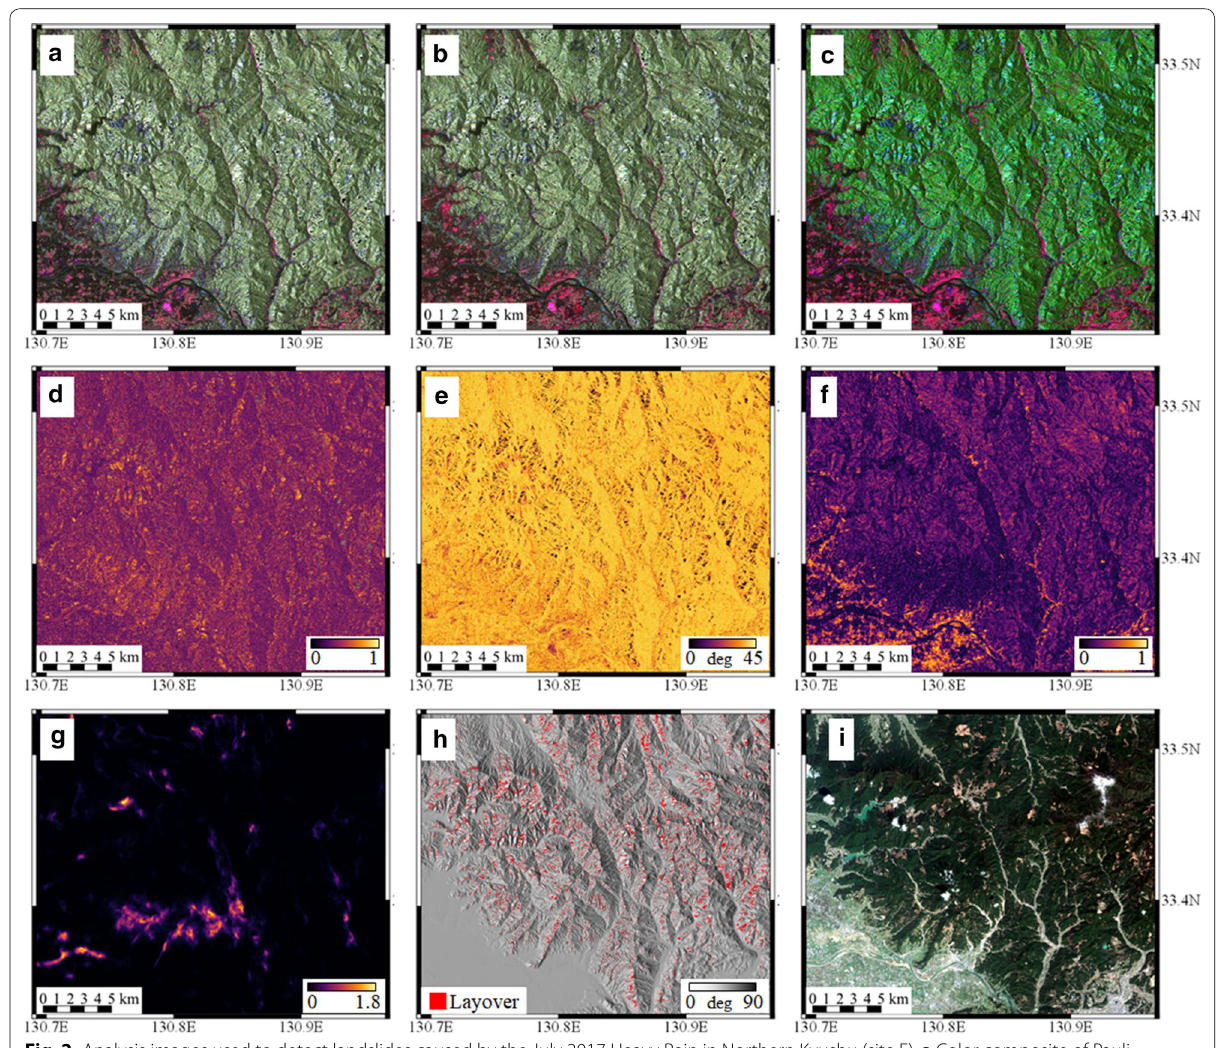
Fig. 2 Analysis images used to detect landslides caused by the July 2017 Heavy Rain in Northern Kyushu (site F). a Color composite of Pauli components (R:G:B T 22 : T 33 : T 11 HH VV:HV:HH VV) of co-event data, b Pauli components of pre-event data, c color composite of the = = + − four-component decomposition (R:G:B Double:Volume:Surface scattering), d polarimetric coherence, e Eigen value parameter, f interferometric = coherence, g phase variation computed from filtered interferometric phase, h local incidence angle derived from DEM with the layover areas overlaid in red color, i optical image by Sentinel-2 acquired on October 20, 2017 (only for visual comparison, not used in